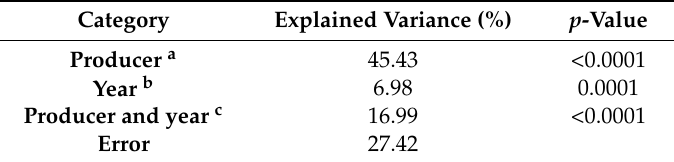
Table 2. Explained variance and significance by 50–50 MANOVA (multivariate analysis of variance) for the MCR (multivariate curve resolution) components based on samples collected days 63 and 91 from the mid-level of the